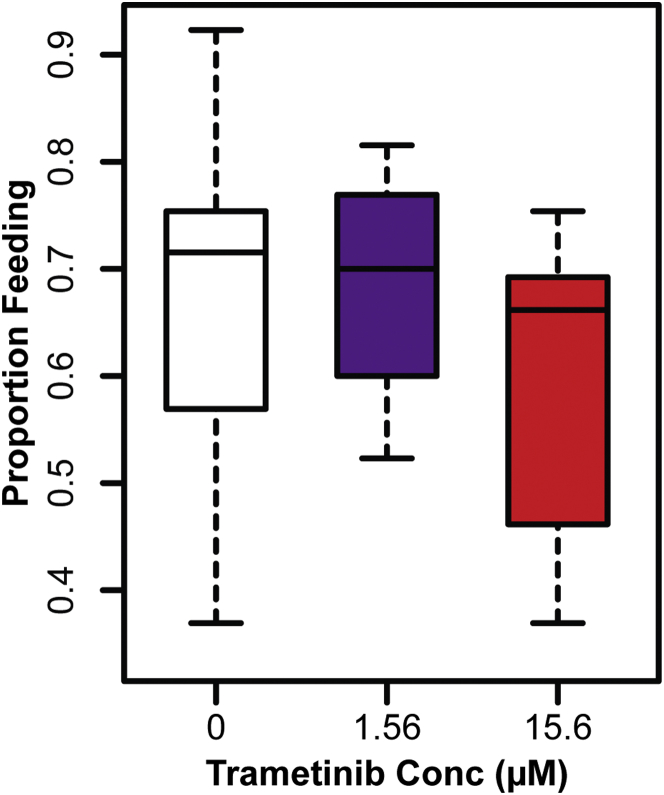
Trametinib Does Not Affect Feeding Behavior, Related to Figure 5Feeding events as a proportion of total events observed per vial for wDah females on food containing 0 μM, 1.56 μM and 15.6 μM trametinib (15 vials per condition). Data were analyzed using a Generalized Linear Model with binomial distribution and overdispersion parameter. There was no significant effect of trametinib concentration on feeding (p = 0.66).